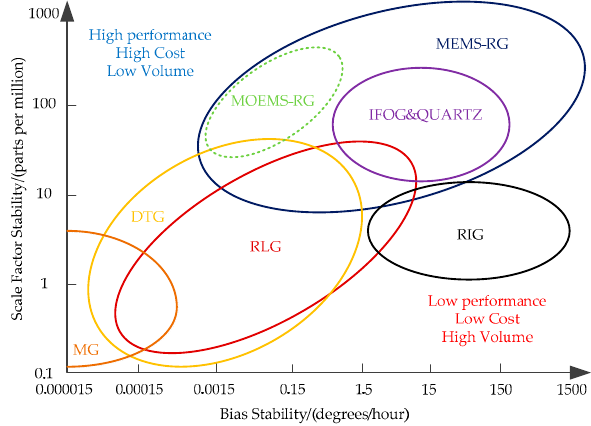
Figure 20. Performance comparison of various types of resonator gyroscope. Mechanical Gyroscopes (MG), Ring Laser Gyroscopes (RLG), Interferometric Fiber-Optic Gyroscopes (IFOG), Quartz, Dynamically Tuned Gyroscopes (DTG), Rate and Integrating Gyroscopes (RIG), Micro Electromechanical System Resonator Gyroscope (MEMS-RG) and MOEMS-RG.